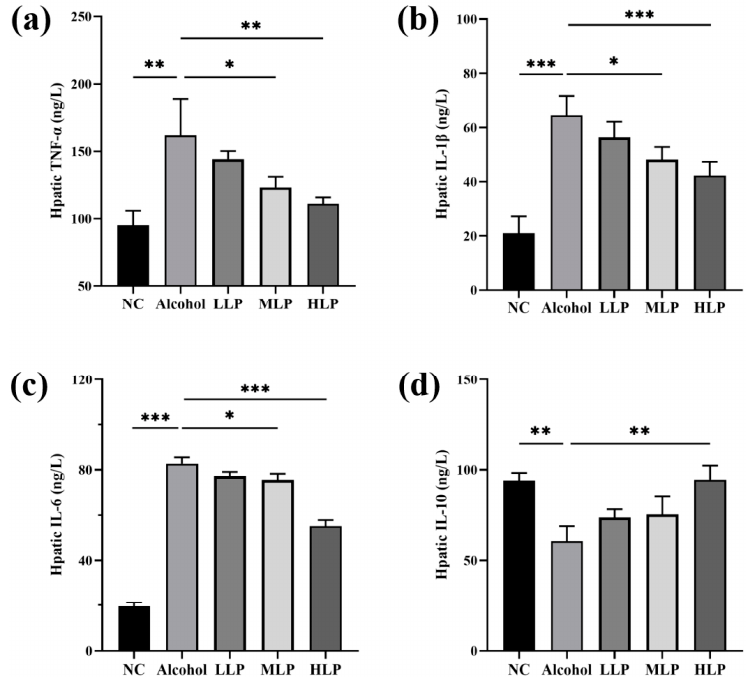
Figure 6. Effects of L. plantarum J26 on liver inflammatory factors. ( a ): TNF- α content; ( b ): IL-1 β content; ( c ): IL-6 content; ( d ): IL-10 content. TNF- α , tumor necrosis factor- α ; IL-1 β , interleukin-1 β ; IL-6, interleukin-6; IL-10, interleukin-10; NC, normal control; LLP, low-dose L. plantarum J26; MLP, medium-dose L. plantarum J26; HLP, high-dose L. plantarum J26. The data were analyzed with a one-way ANOVA and expressed as means ± SD ( n = 6). * p < 0.05, ** p < 0.01 and *** p < 0.001 compared with the Alcohol group.